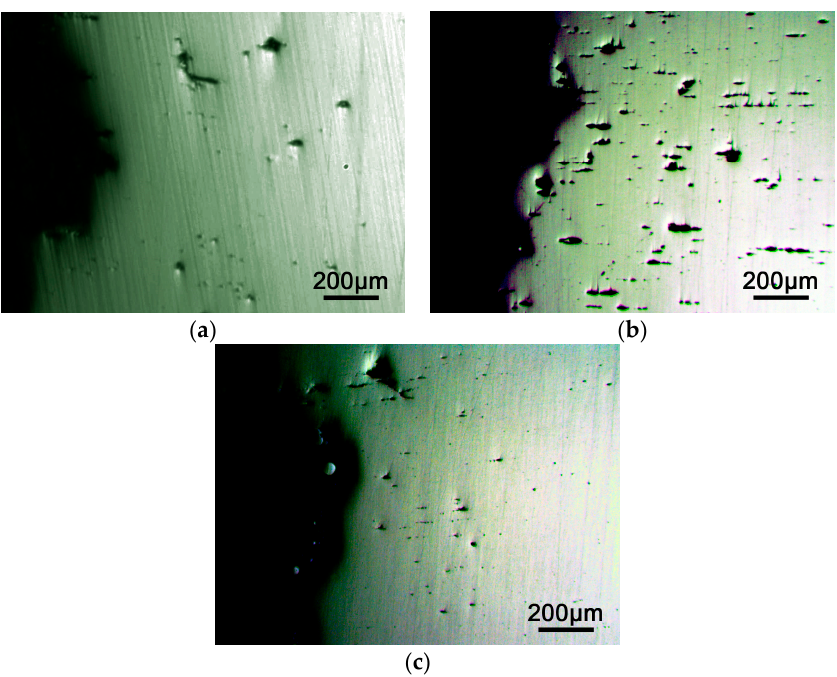
Figure 4. Morphology of voids near the fracture tip in the specimens tested under 150 MPa at 873 K: ( a ) undoped steel ruptured after 1010 h; ( b ) Sb ‐ doped steel ruptured after 423 h; ( c ) Sb+Ce ‐ doped ( a ) undoped steel ruptured after 1010 h; ( b ) Sb-doped steel ruptured after 423 h; ( c ) Sb+Ce-doped steel steel ruptured after 601 h. ruptured after 601